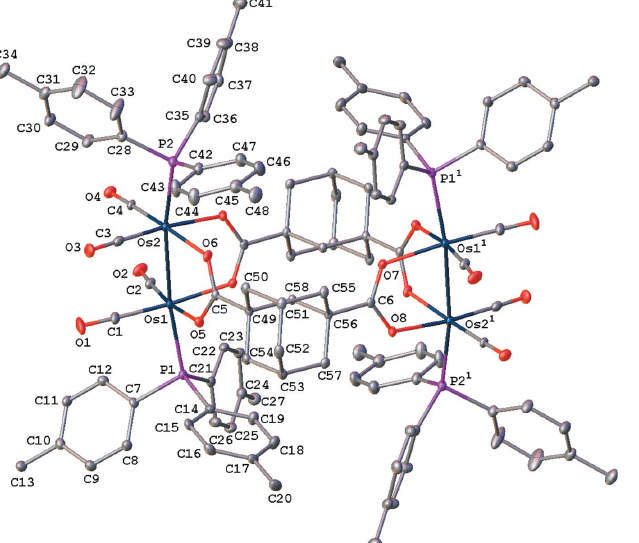
Figure 1 View of the title molecule showing the atom-labeling scheme. Displace- ment ellipsoids are scaled to the 35% probability level. For the sake of clarity, all H atoms are omitted. [Symmetry code: (1) 1 (cid:4) x , 1 (cid:4) y , 1 – z